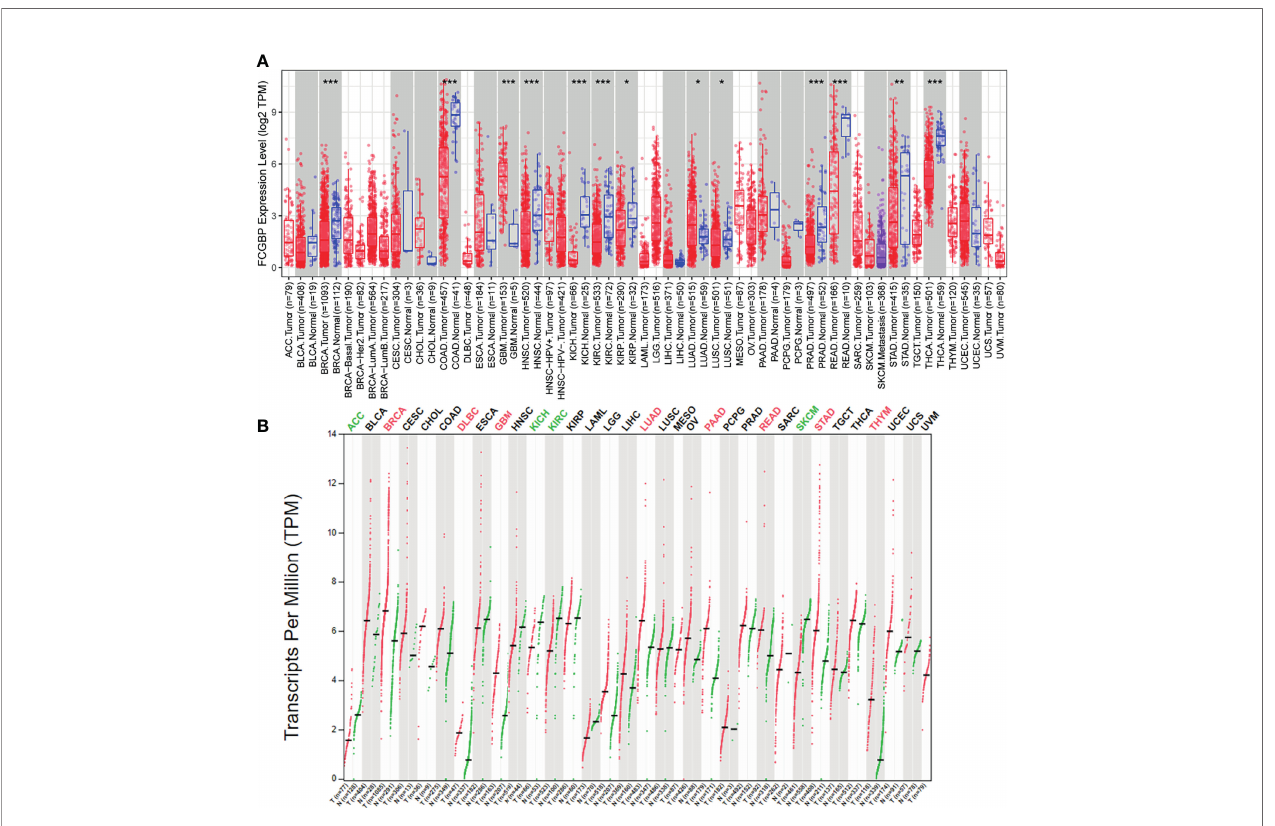
FIGURE 1 | The expression FCGBP in different cancer tissues (A) The mRNA expression levels of FCGBP in different tumor tissues and normal tissues analyzed by TIMER (* P <.05, ** P <.01, *** P <.001). (B) Transcription level of FCGBP was determined in different tumor tissues and normal tissues by GEPIA (* P <.05, ** P <.01, *** P